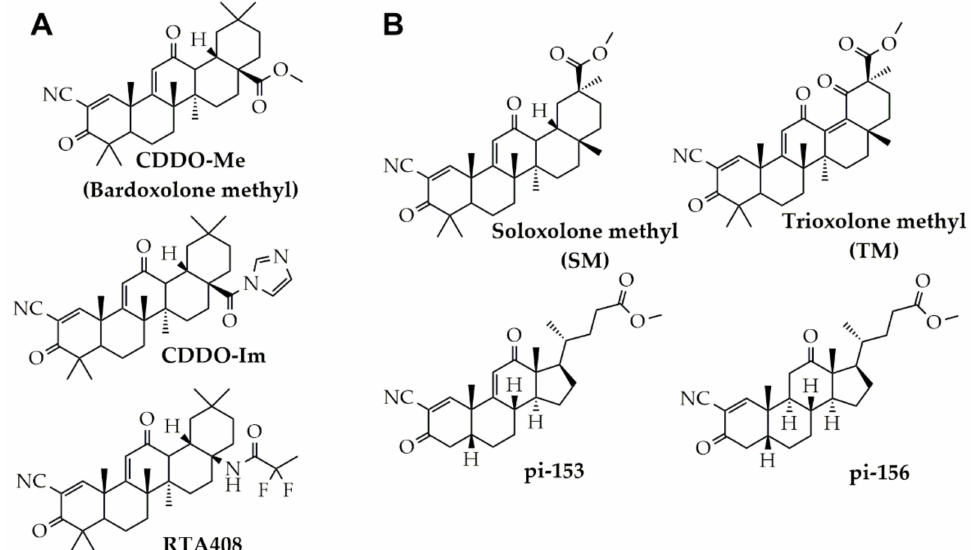
Figure 1. The chemical structures of cyano enone-containing semisynthetic triterpenoids and steroids. ( A ) Bioactive cyano enone-bearing triterpenoids. ( B ) Compounds under the